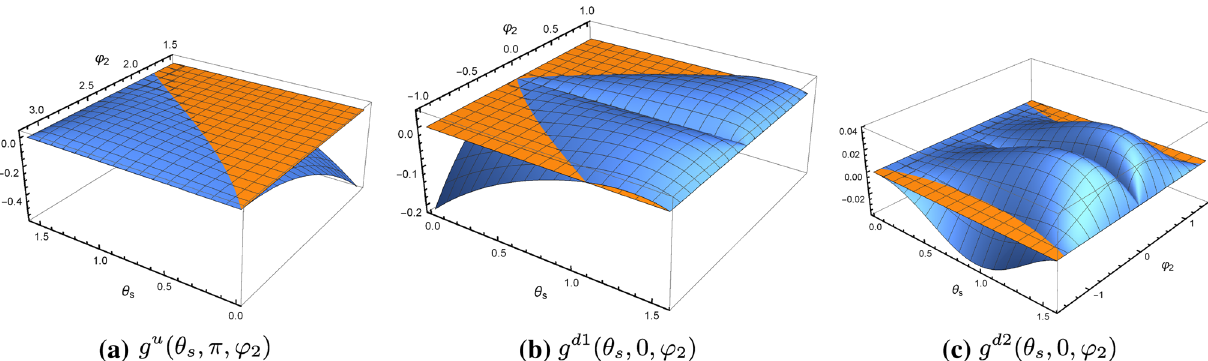
Fig. 4 LI violation in case θ s is a variable. The maxima of g u , g d 1 and g d 2 are still at ϕ 1 = π, 0 , 0, respectively. g u (θ s ,π,ϕ 2 ) , g d 1 (θ s , 0 ,ϕ 2 ) and g d 2 (θ s , 0 ,ϕ 2 ) are functions of θ s and ϕ 2